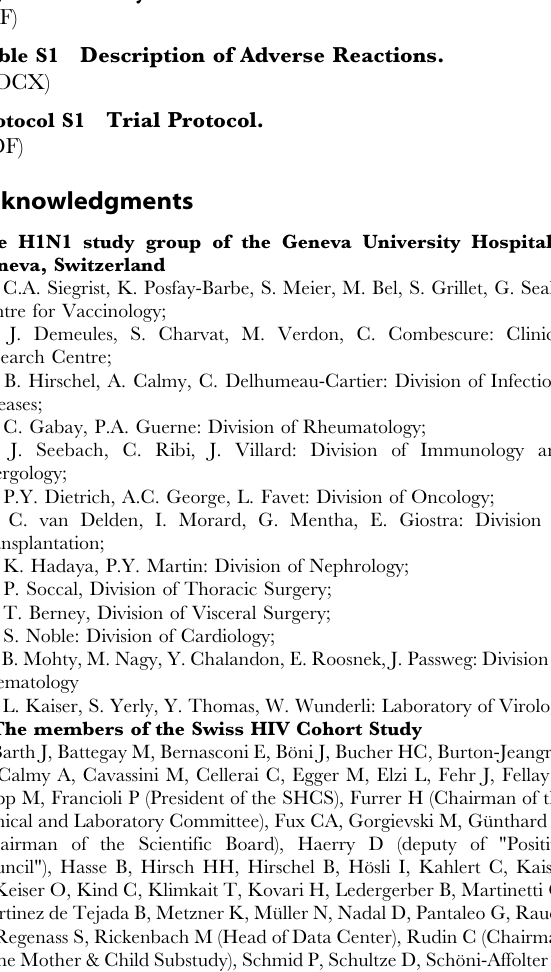
Figure S1 Study Flow Chart. Table S1 Description of Adverse Reactions.